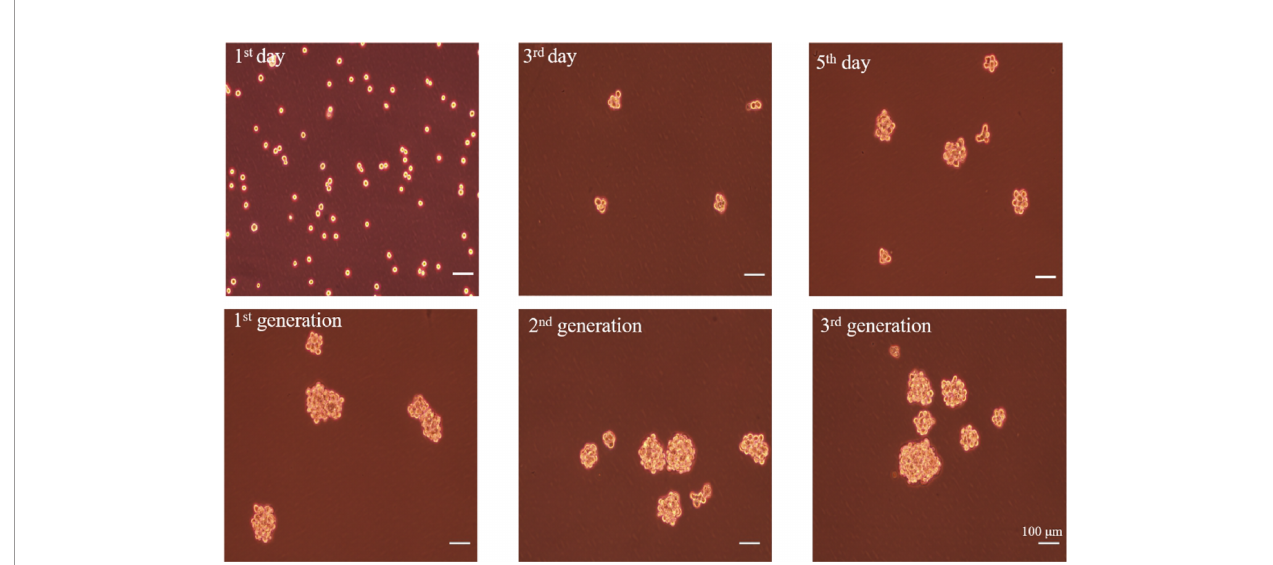
FIGURE 6 | The formation of A549 CSCs induced by serum-free suspension culture. Top, 1-day, 3-day, and 5-day phases of spheres in SFM. Bottom, one- generation, two-generation, and three-generation phases of spheres in SFM. The bar represents a distance of 100 m m.